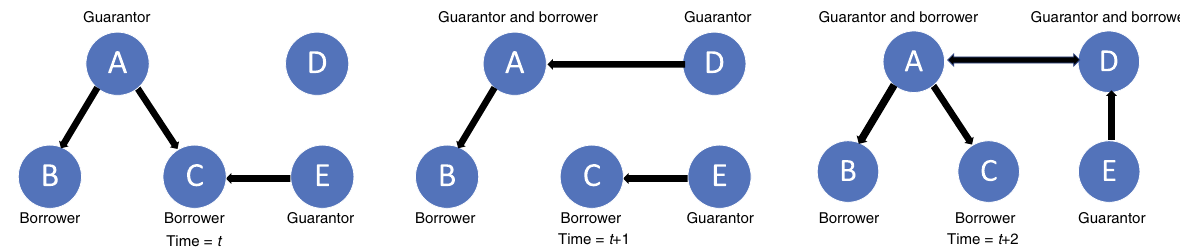
Fig. 6 Illustration of the dynamic loan guarantee relationships in the guarantee network. In time t , there are three guarantee relationships. Firm A was the guarantor for borrowers B and C. Firm E was the guarantor for borrower C. In time t + 1, the guarantee relationship between A and C was gone after C repaid the loans. Firm D became the guarantor for A, who was both a guarantor and a borrower. In time t + 2, the guarantee relationship between C and E was gone. Firm E became the guarantor for fi rm D. Firm A became the guarantor for fi rm D, which is also the guarantor for fi rm A. Firms A and D formed the mutual guarantee relationship